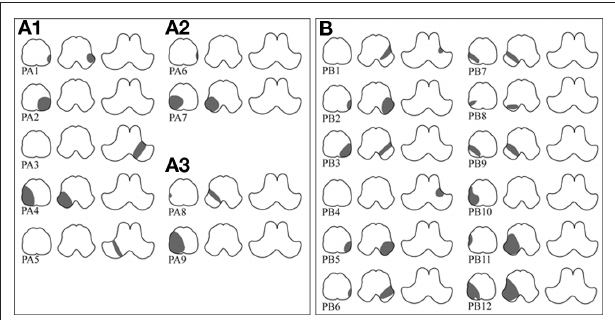
FiGuRe 1 | Topographic distribution of lateral medullary infarction in patients with abnormal (a) and norma l (b) cervical vestibular-evoked myogenic potential (cVeMP) . In the abnormal group (a) , the lesions are also arranged according to the side of cVEMP abnormality; ipsilesional (a1) , contralesional (a2) , and bilateral (a3) . The lesions in normal group are shown in (b) .